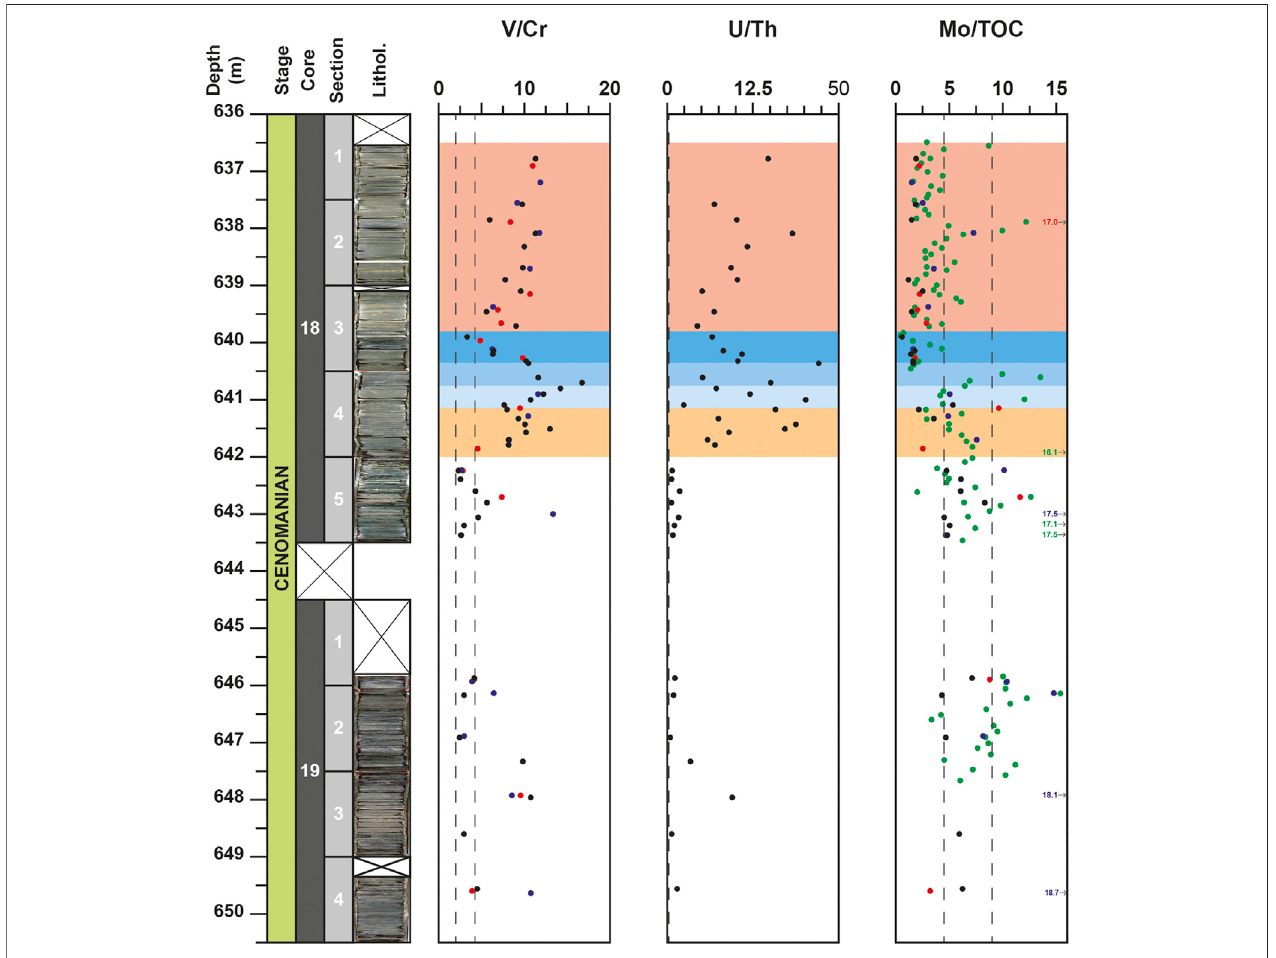
FIGURE 8 | Depth-pro fi les for V/Cr, U/Th and Mo/C org redox ratios for the DSDP site 367. Datafrom the studies of Kuypers et al. (2002) and Kuypers et al. (2004), Westermann et al. (2014) and Dickson et al. (2016) are represented with blue, red and green circles respectively. Vertical dotted lines represent the threshold values (2.0 and 4.25 for V/Cr and 0.75 and 1.25 for U/Th) de fi ned by Jones and Manning (1994) to distinguish oxic, dysoxic and anoxic